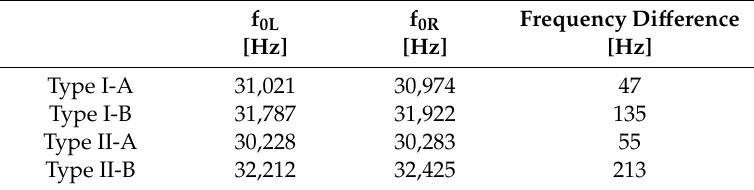
Table 3. Output frequency di ff erence in the two DETF resonators.